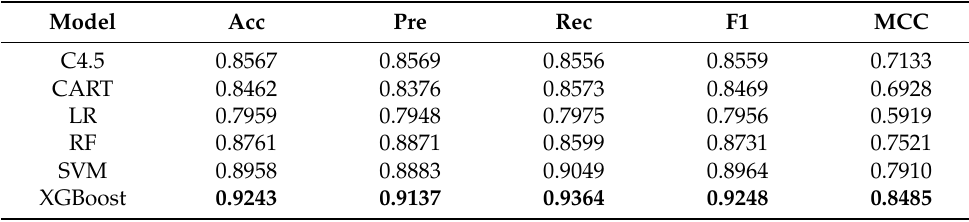
Table 4. Generalizing model for the two-level stress classification (mid and low stresses).